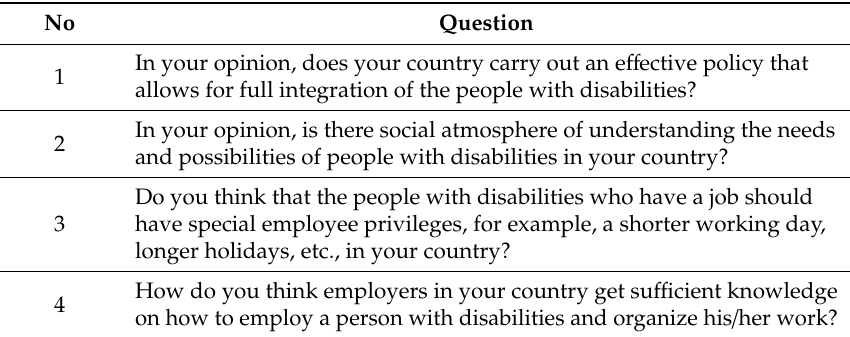
Table 1. Analyzed questions from the proprietary